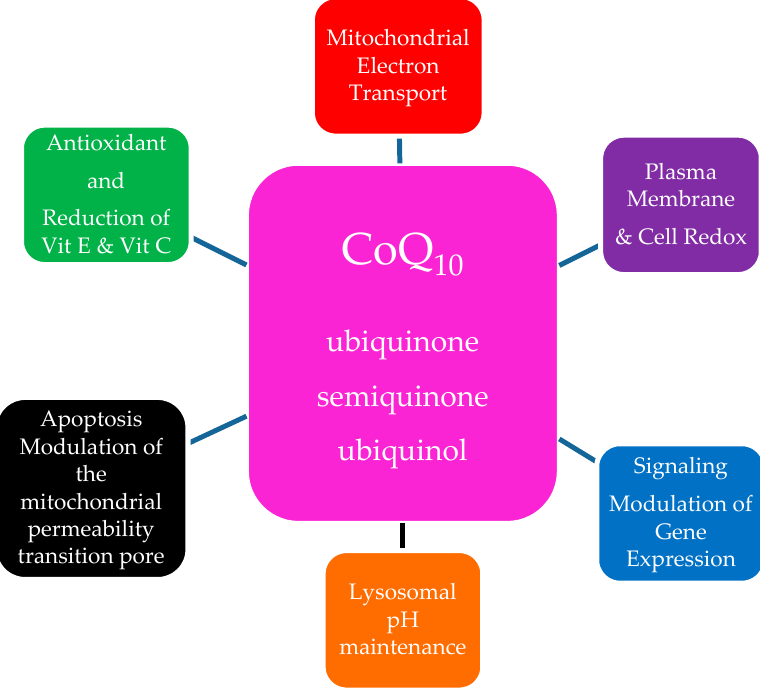
Figure 2. The Multiple Roles of Ubiquinone in the Cell .